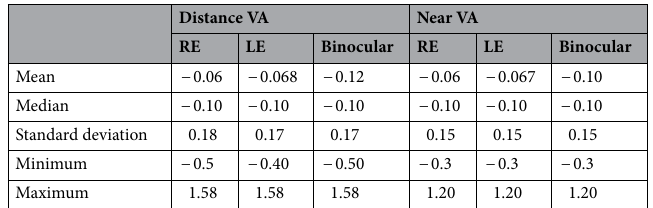
Table 1. Measured habitual LogMAR VA for all students. RE Right eye, LE Left eye.